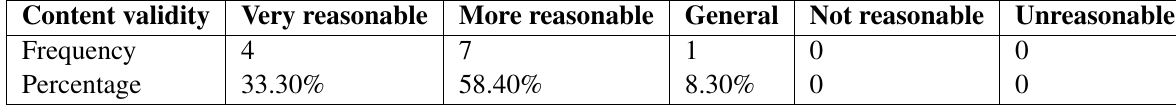
Table 3 Test of the content validity of the questionnaire